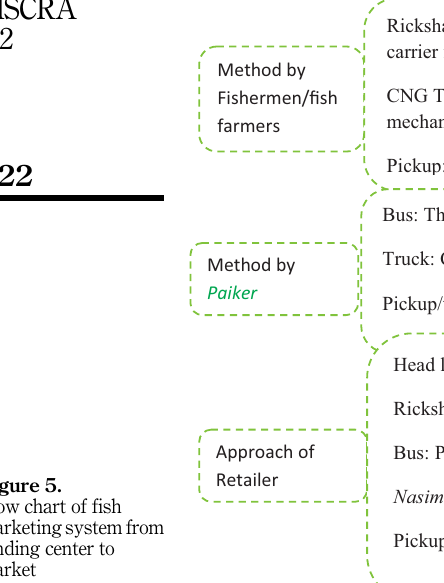
Figure 5. Flow chart of fish marketingsystemfrom landing center to